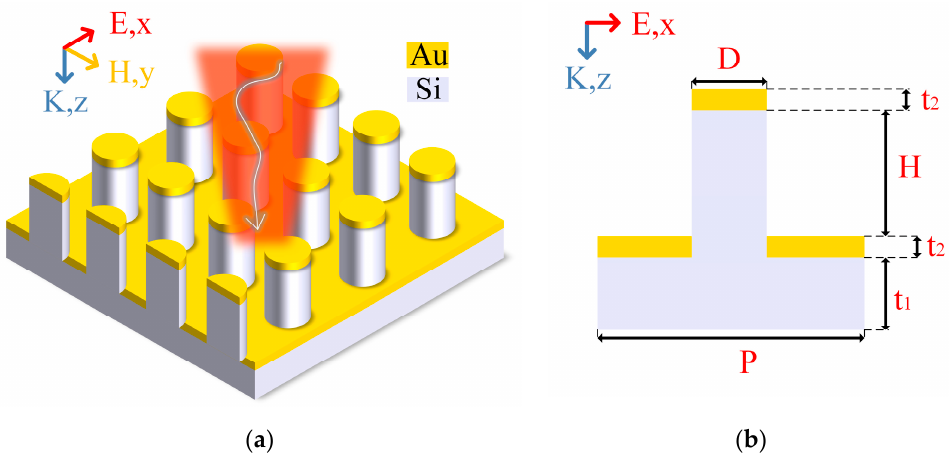
Figure 1. ( a ) Schematic of the proposed Au/Si NP arrays/Au perfect absorption photodetector. ( b ) The structure parameters are t 1 = 1 μ m, t 2 = 0.015 μ m, H = 0.12 μ m, D = 0.13 μ m, and P = 0.2 μ m.